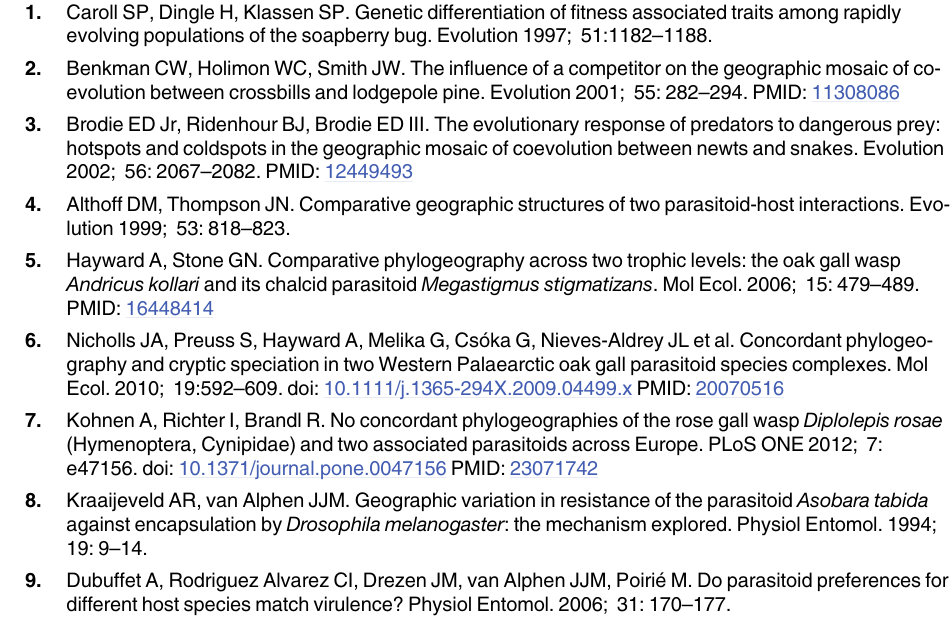
S1 Table. Host acceptance experiment results. S2 Table. Host suitability experiment